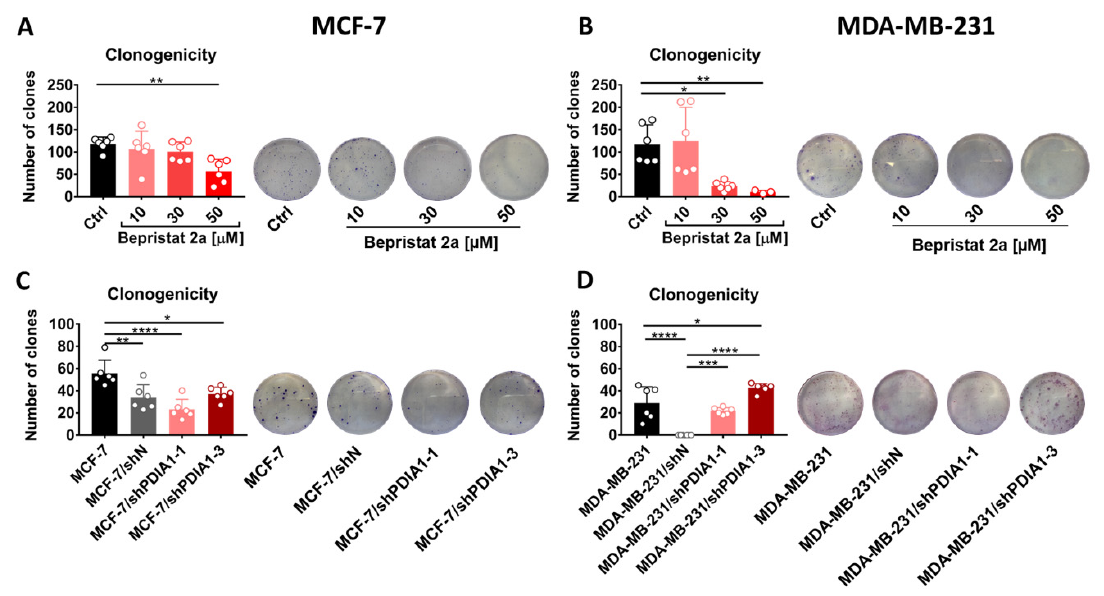
Figure 1. Effect of PDIA1 inhibition on clonogenic capacity of breast cancer cells. The clonogenicity of MCF-7 ( A ) and MDA-MB-231 ( B ) cells treated with bepristat 2a as well as MCF-7 ( C ) and MDA-MB-231 ( D ) cells transduced with lentiviral vectors carrying short hairpin RNA (shRNA) against PDIA1 or negative sequence after selection with puromycin in regarding to wild type cell line. Data represent the means ± SD with points for individual measurements, the representative photos are also presented. Statistical analysis was calculated using parametric one-way ANOVA followed by Dunnett’s multiple comparisons test (* p = 0.05, ** p = 0.01, *** p = 0.001, **** p = 0.0001).